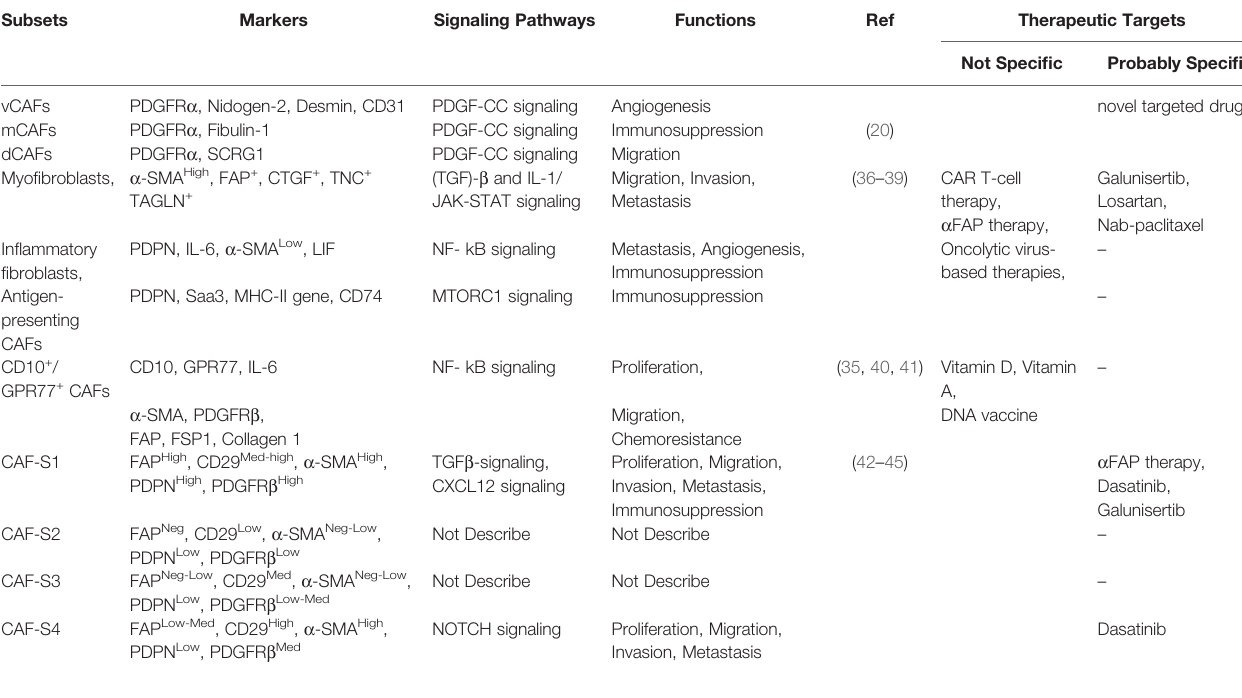
TABLE 2 | Heterogeneity of CAFs and therapeutic